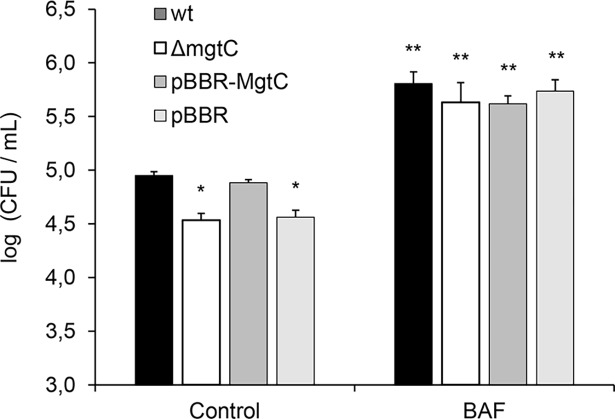
Treatment of THP-1 cells with bafilomycin A1 restores the intracellular survival defect of B. pertussis mgtC deletion mutant strain to wild type B. pertussis levels.THP-1 macrophages were treated with 50 nM bafilomycin A1 (BAF) dissolved in DMSO or with DMSO alone (control condition) for 1 hour prior infection with either wild type B. pertussis (wt), B. pertussis mgtC deficient mutant (ΔmgtC), B. pertussis mgtC deficient mutant carrying the pBBR1MCS vector (pBBR), and B. pertussis mgtC deficient mutant carrying a pBBR1MCS derivative that encodes mgtC (pBBR-mgtC). After 2 h of infection cells were treated with polymyxin B and 48 hours after infection intracellular survival was assessed by lysing cells and enumerating CFUs. The means ± SD of triplicates of one representative experiment out of two performed are given. The survival of the ΔmgtC and pBBR strains in control conditions was significantly different from the survival of the wt and pBBR-mgtC strains in control conditions. Statistical significance analysis was performed using one-way ANOVA (*P<0.05). The survival of wt, ΔmgtC, pBBR, and pBBR-mgtC strains in BAF treated cells was significantly higher than the survival of any of these strains in untreated cells (control conditions). Statistical significance analysis was performed using one-way ANOVA (**P<0.05).